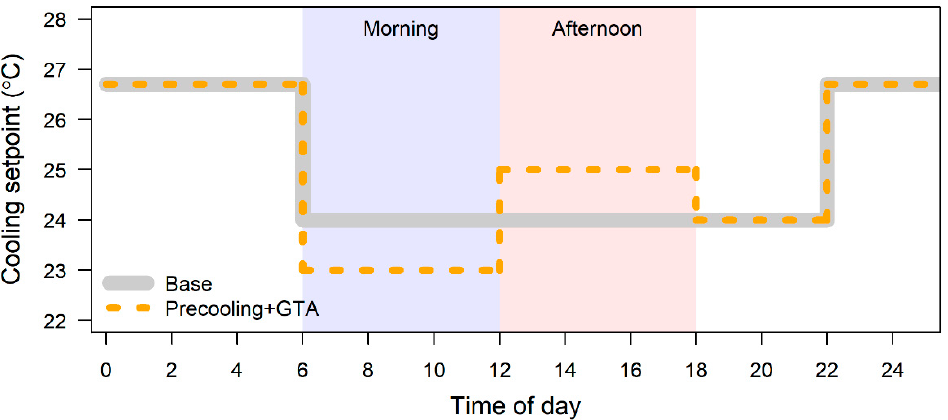
Figure 4. Cooling temperature setpoint schedules for Base and Precooling + GTA scenarios.